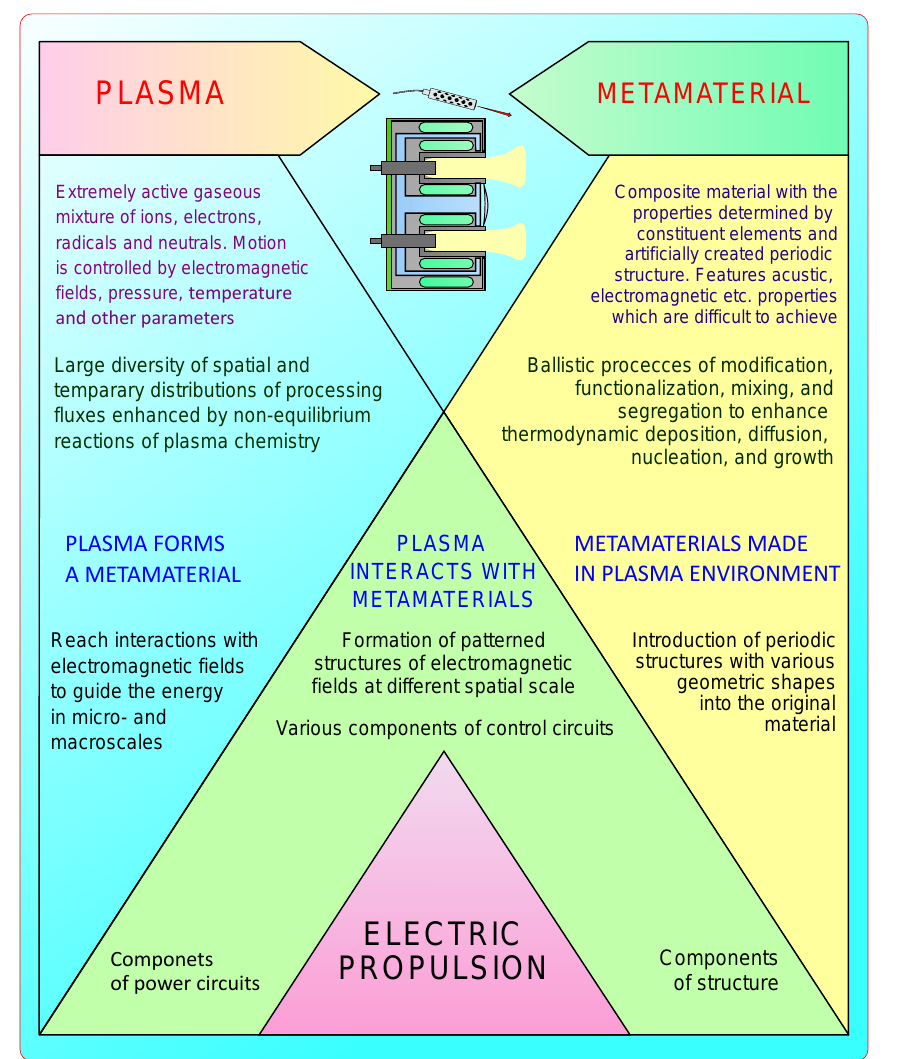
Figure 8. Plasmas and metamaterials: interrelated processes and properties create new capabilities. Different pathways are possible to enhance the characteristics of space propulsion systems via metamaterial-inspired technologies. Plasma can be used directly to create the novel metamaterials for space applications; plasma can interact with metamaterials to produce novel effects, e.g., a type of virtual antenna; and plasma itself could be a type of metamaterial.